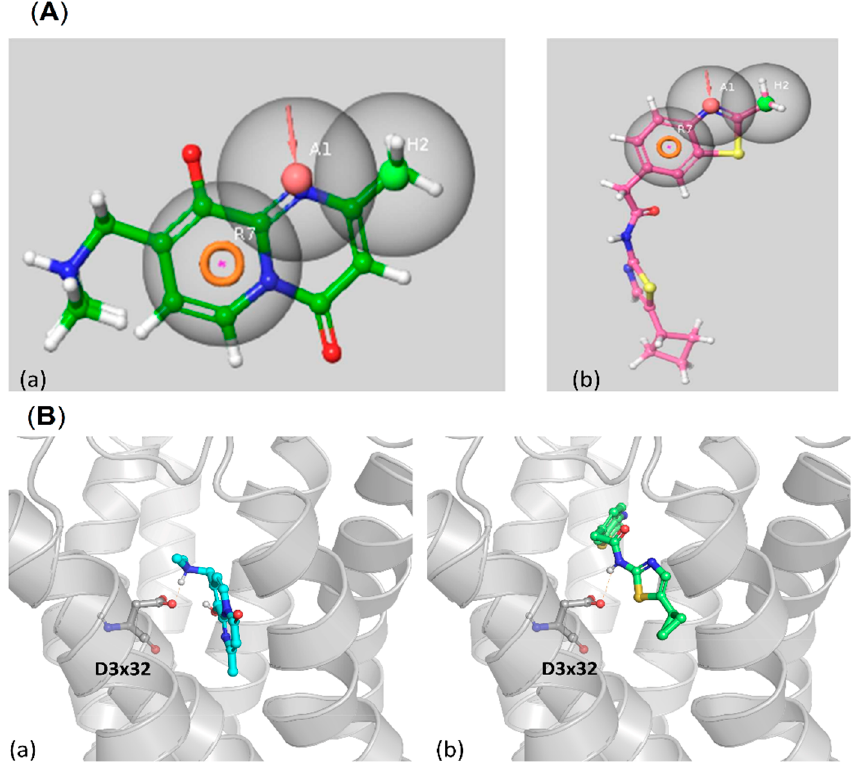
Figure 16. Examples of CDK5 ligands which were successfully mapped to the 5-HT 6 R pharmacophore model ( A ) together with their docking results ( B ); ( a ) 44 , ( b ) 47.